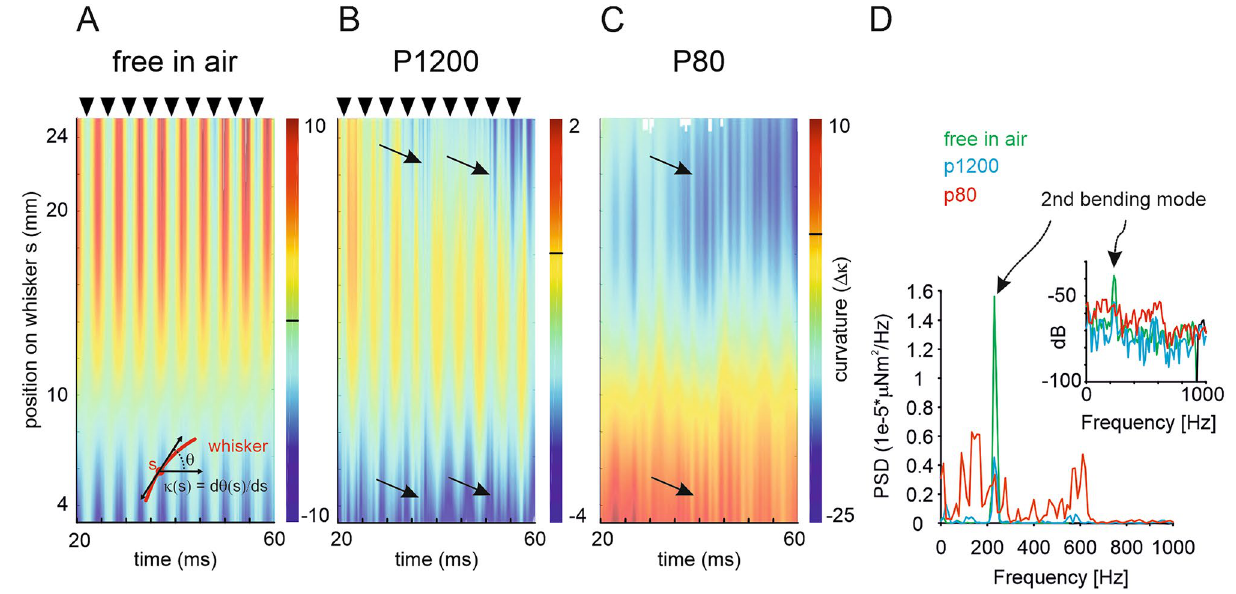
Figure 2. Curvature of the whisker in moving contact. ( A ) Movement in air. Curvature of each point along the beam and across time is colour coded. Inset: Calculation of curvature κ . The angle θ at each point of the beam is measured and the curvature calculated as κ( s ) of the whisker (at rest in air) is subtracted. ( B ) Curvature as in A when in contact with a smooth sandpaper (P1200) and ( C ) a rough sandpaper (P80). For both the distance was (distance x Arrows point to curvature changes evoked by stick–slip events being transmitted rapidly along the beam and therefore appearing as vertical stripes. ( D ) Spectra of base movements shown in ABC. Inset shows the same data rescaled to dB. Note the prominent peak in the spectrum at ~ 200 Hz in the ‘free in air’ condition, indicating the 2nd bending